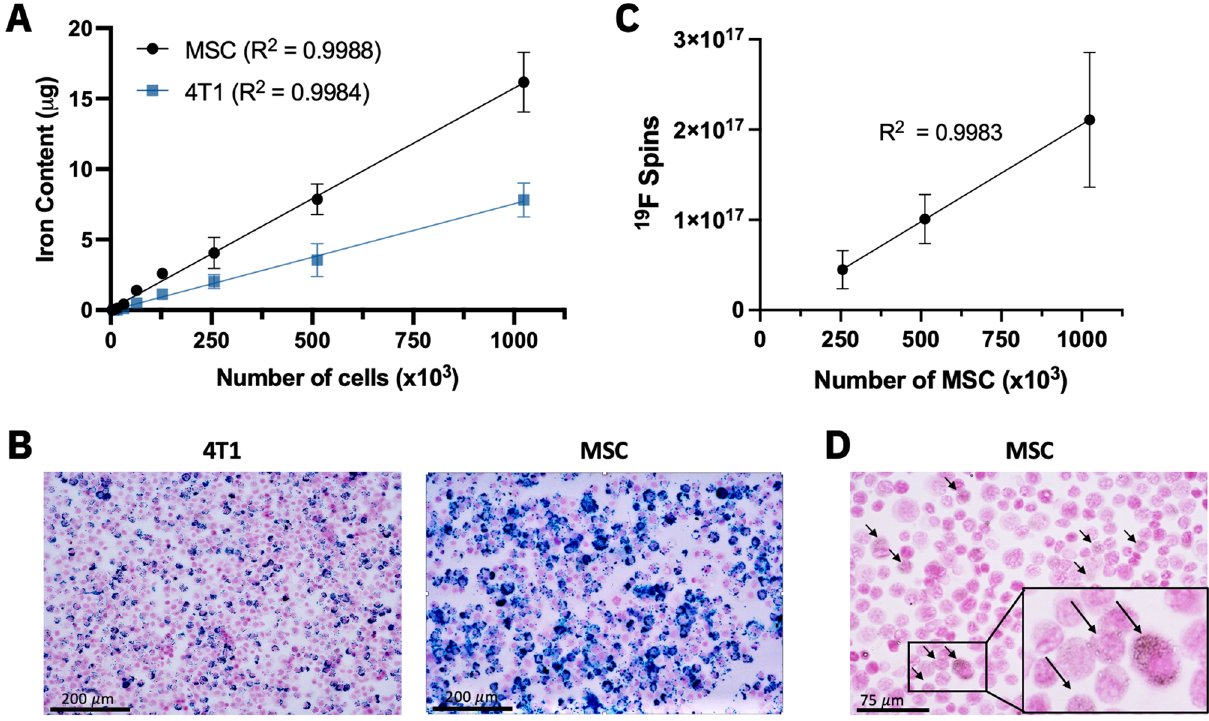
Figure 5. ( A ) The number of ferucarbotran-labeled MSC and 4T1 cells is strongly correlated with iron content measured by MPI (R 2 > 0.998). The slope of the line for MSC is higher than 4T1 ( P < .0001), indicating higher sensitivity and enhanced uptake of iron in MSC compared to 4T1 cells as shown with PPB stain ( B ). ( C ) A strong linear correlation exists between the number of PFPE-labeled MSC and detected 19 F signal (R 2 = 0.9983). ( D ) PFPE labeling identified as nanodroplets in microscopy (black arrows).